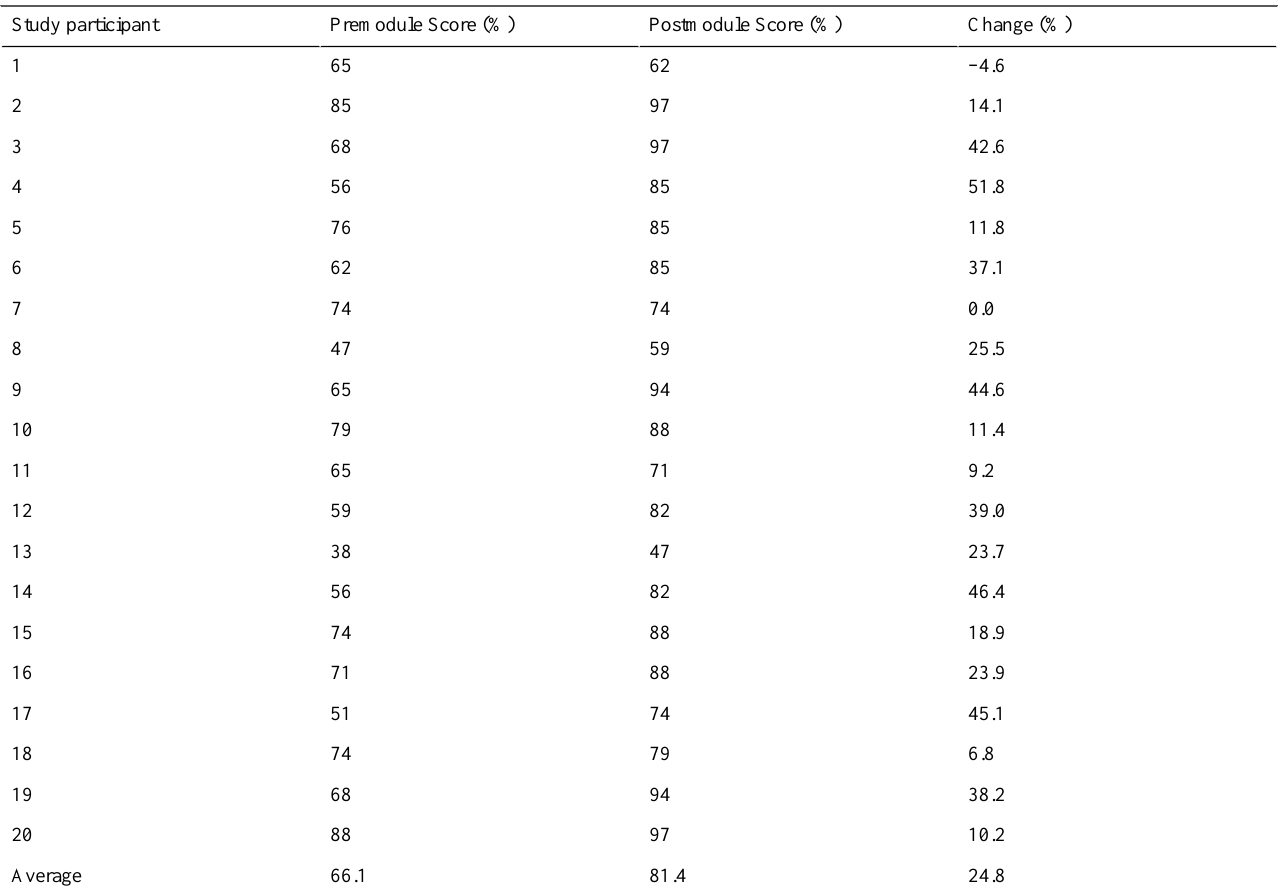
Table 1. Premodule versus postmodule questionnaire